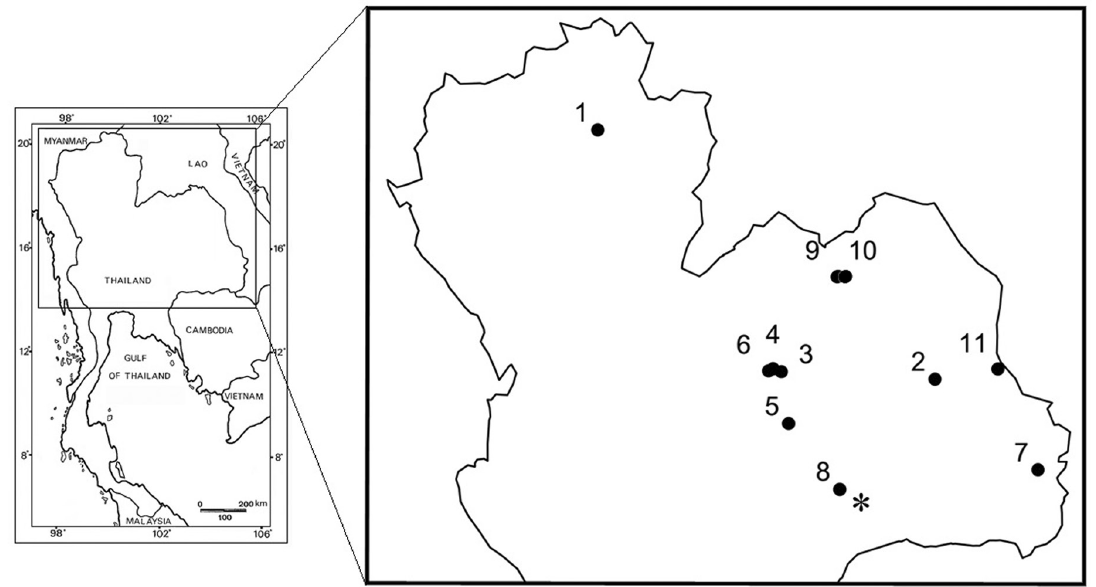
Fig. 5. Distribution map of Thaicypridopsis longispinosa sp. nov. (* = type locality; numbers = localities mentioned in “Other material examined”